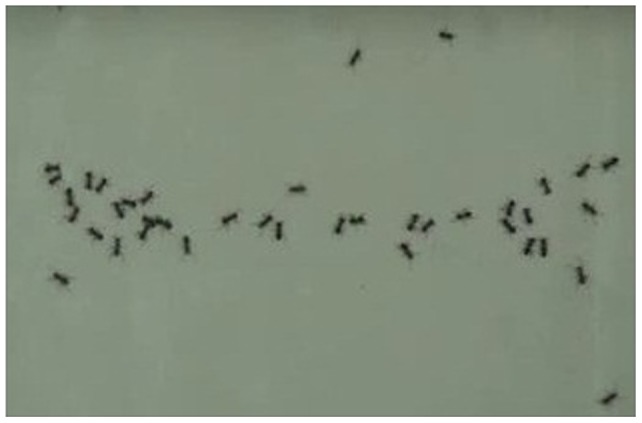
A representative snapshot illustrating a distribution of ants.The wings-out configuration is shown.